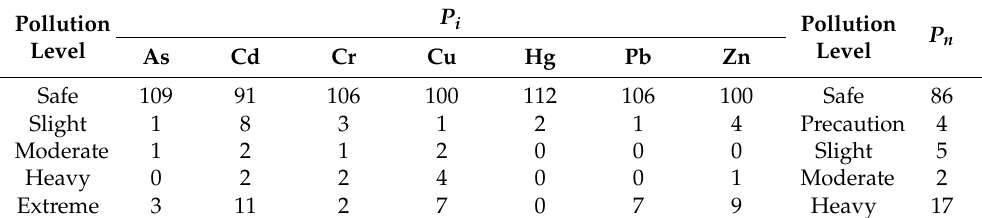
Table 5. Number of different P i and P n levels for surface water samples (n =